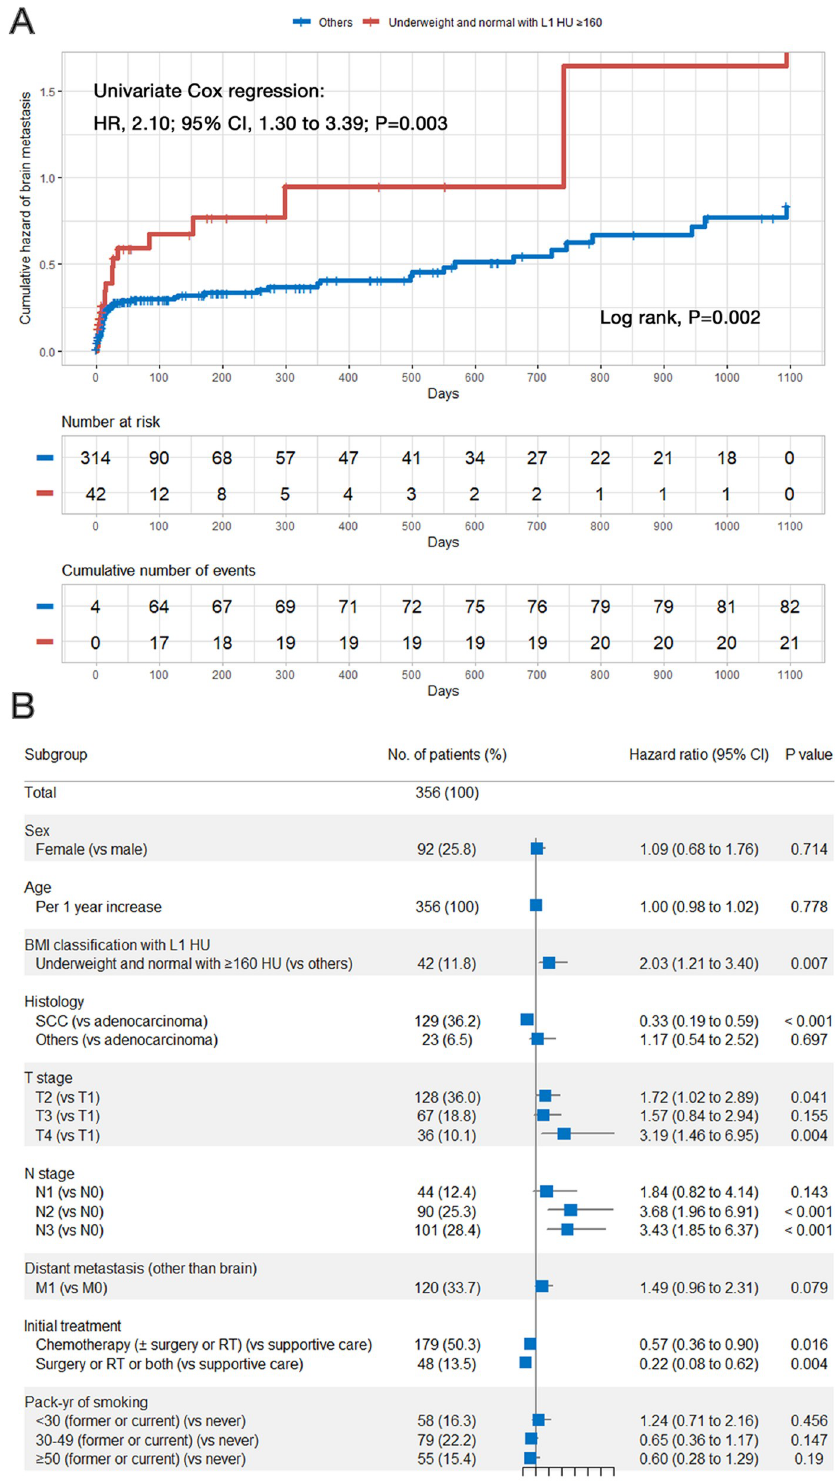
Fig 3. Cumulative hazard curve and forest plot of brain metastasis. (A) Cumulative hazard of brain metastasis in the low BMI with high BMD group and others; (B) Forest plot of estimates from the multivariate Cox regression analysis